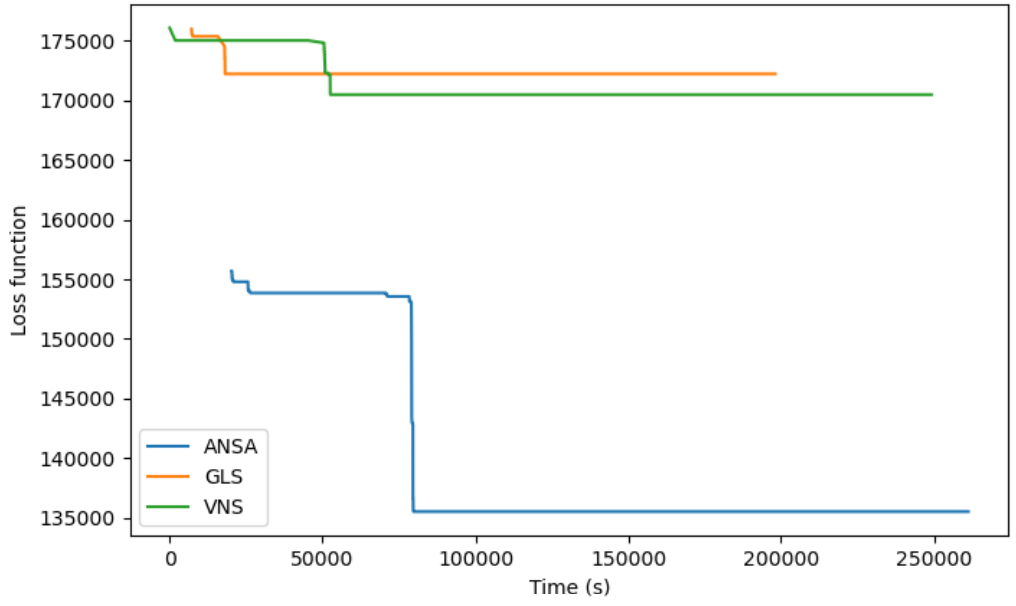
Figure 14. Time evolution of loss function minimum for ten blocked links in the Zlín